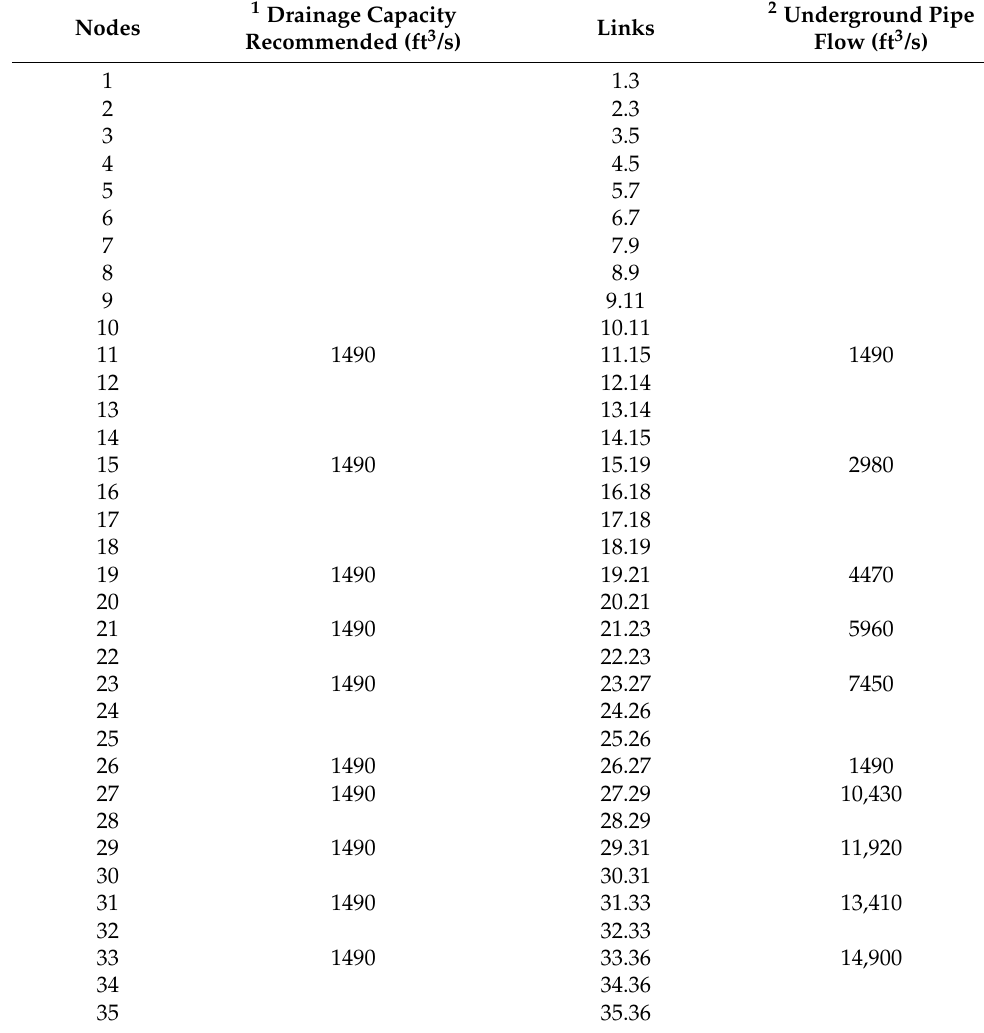
Table 6. Optimization values for London. Arkansas watershed (analysis run for the 100-year storm).